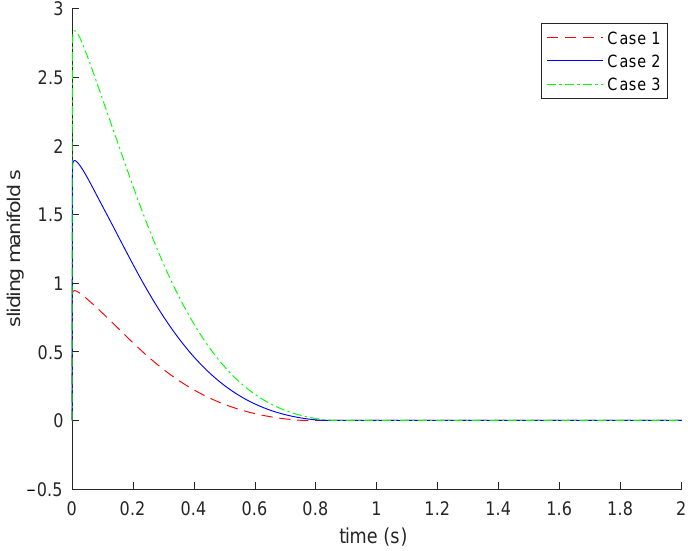
Figure 5. Sliding manifolds in Example 3.